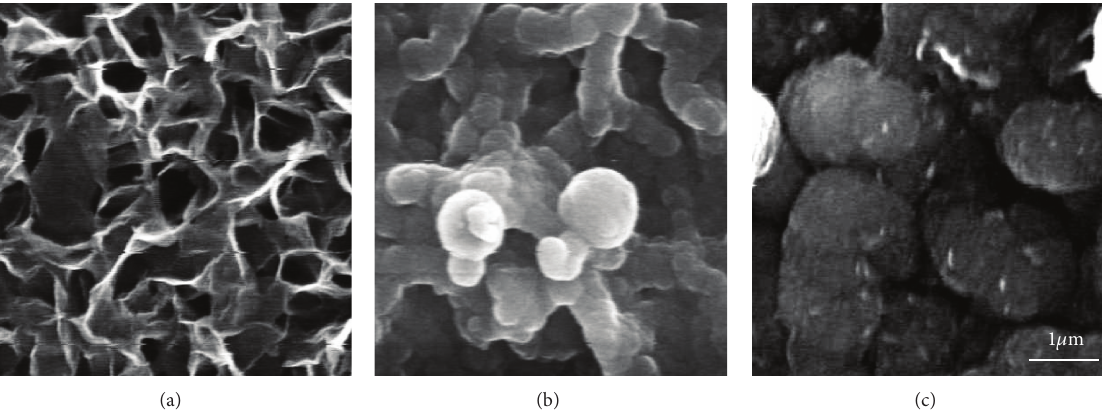
Figure 5: SEM images of coating obtained at − 1.4V before and after immersion in SBF solution for 1 day and 7 days.